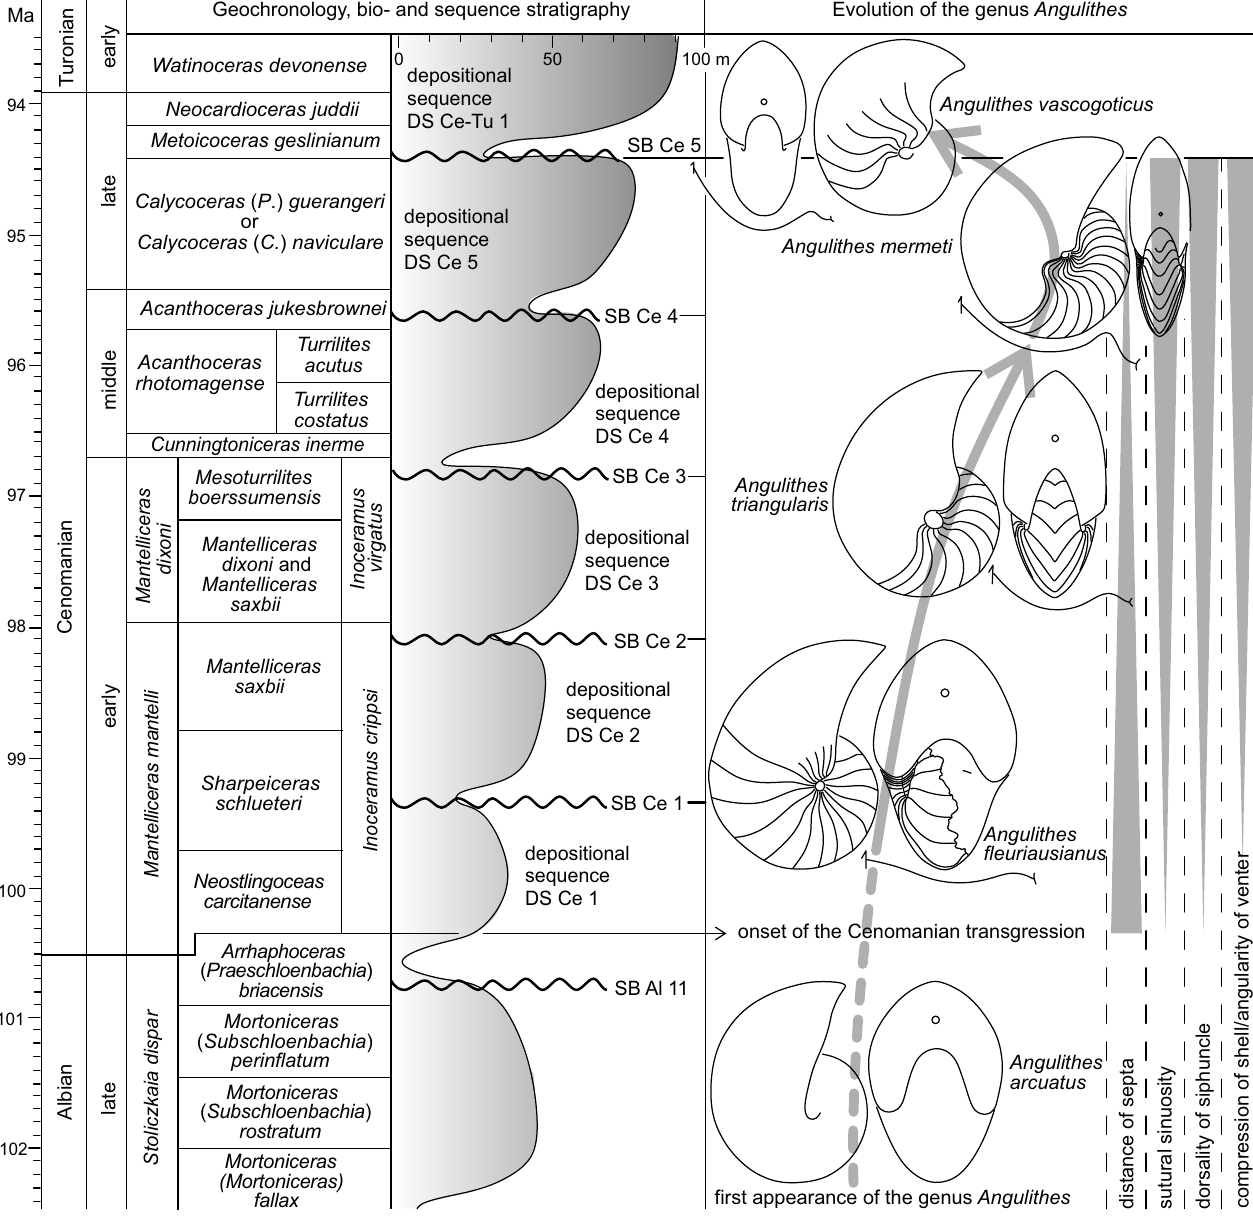
Fig. 11. Geochronology (Ogg and Hinnov 2012), ammonite biostratigraphy (Wright and Kennedy 2017) and sequence stratigraphy (Robaszynski et al. 1998; Wilmsen 2003) of the Cenomanian Stage plotted against evolutionary trends in the hercoglossid nautiloid genus Angulithes . See text for further